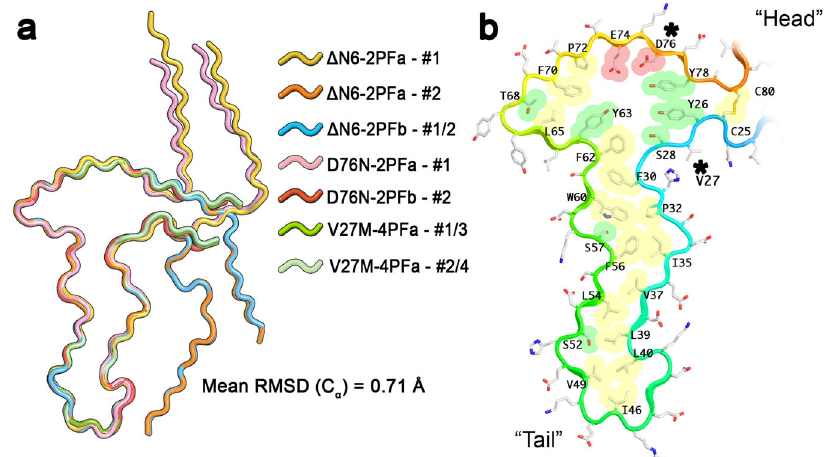
Fig. 6 | The hammer shaped motif is identical in all fi bril structures solved. a Overlay of the seven unique chains in the atomic models built for the β 2 m poly- morphs describedabove. Thereferencewas proto fi lament#1from β 2 m- Δ N6-2PFa, and each unique chain was aligned to the reference across the C α atoms for resi- dues 25 – 80 inclusive. b The hammer-shaped amyloid motif. Again, proto fi lament